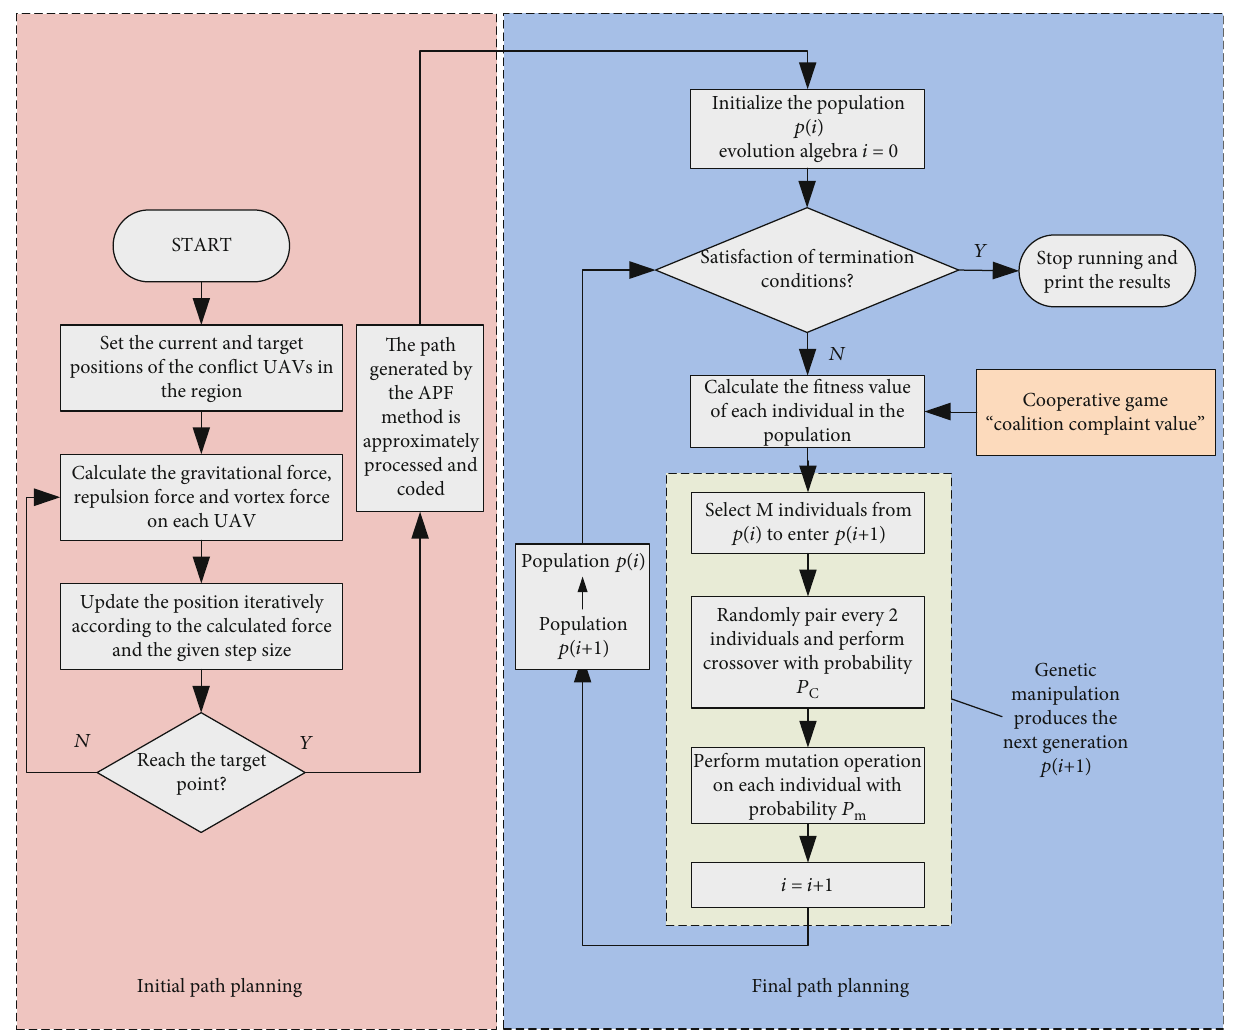
Figure 4: Multi-UAV con fl ict resolution process based on the APF-GA